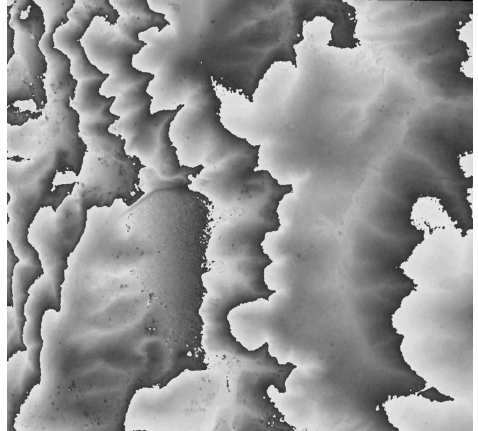
Figure 5. Interferogram generated from the corregistered images of the Figure 4